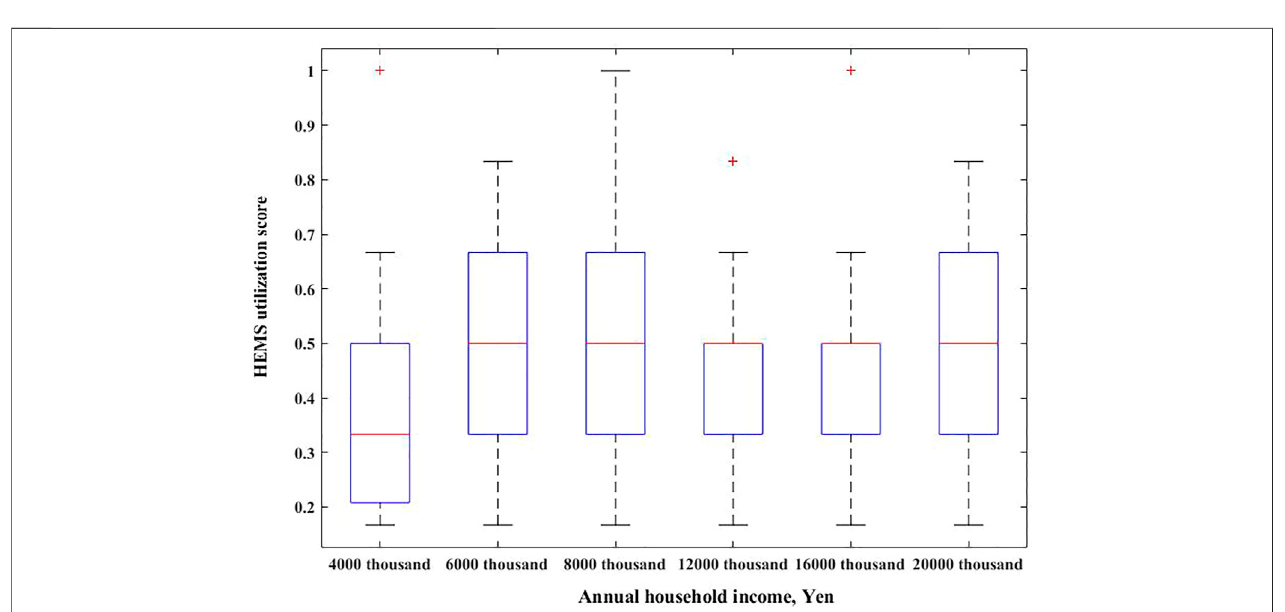
FIGURE 11 | Variations in HEMS utilization scores of all participants with different annual household incomes.